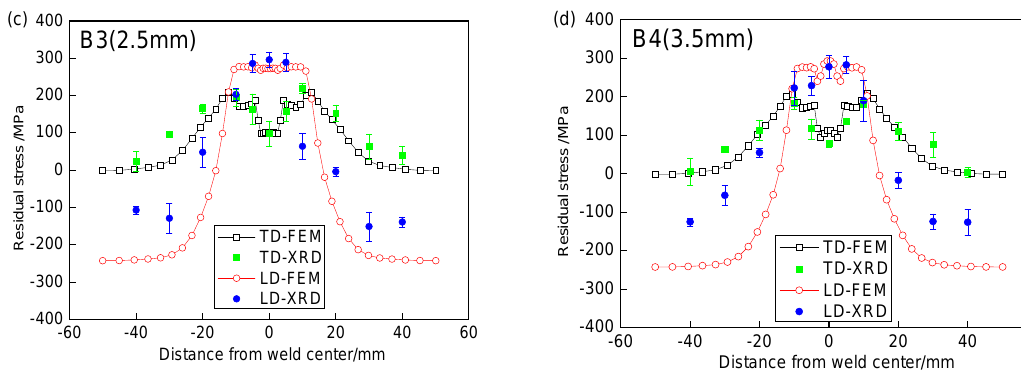
Figure 11. Comparison of residual stresses along P1 by simulation and experiment for different reinforcement heights: ( a ) 0.5 mm, ( b ) 1.0 mm, ( c ) 2.5 mm and ( d ) 3.5 mm.